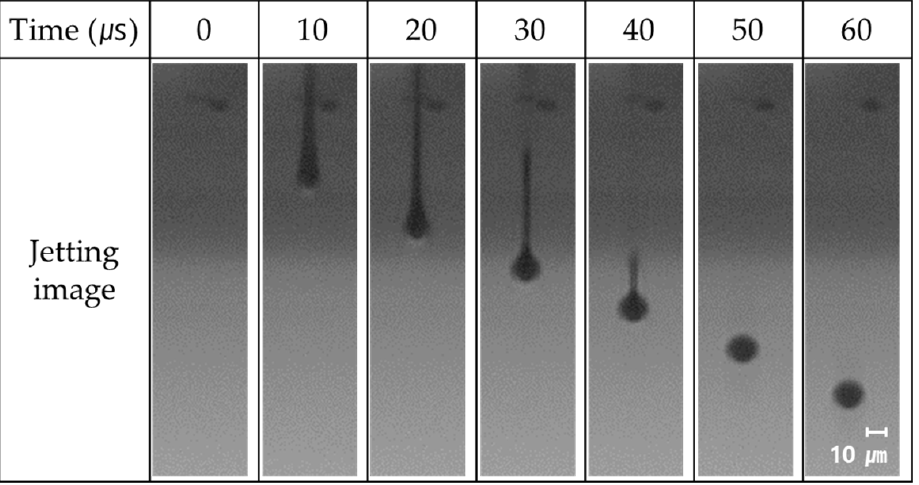
Figure 3. Sequential images of droplet je tt ing from inkjet nozzle.